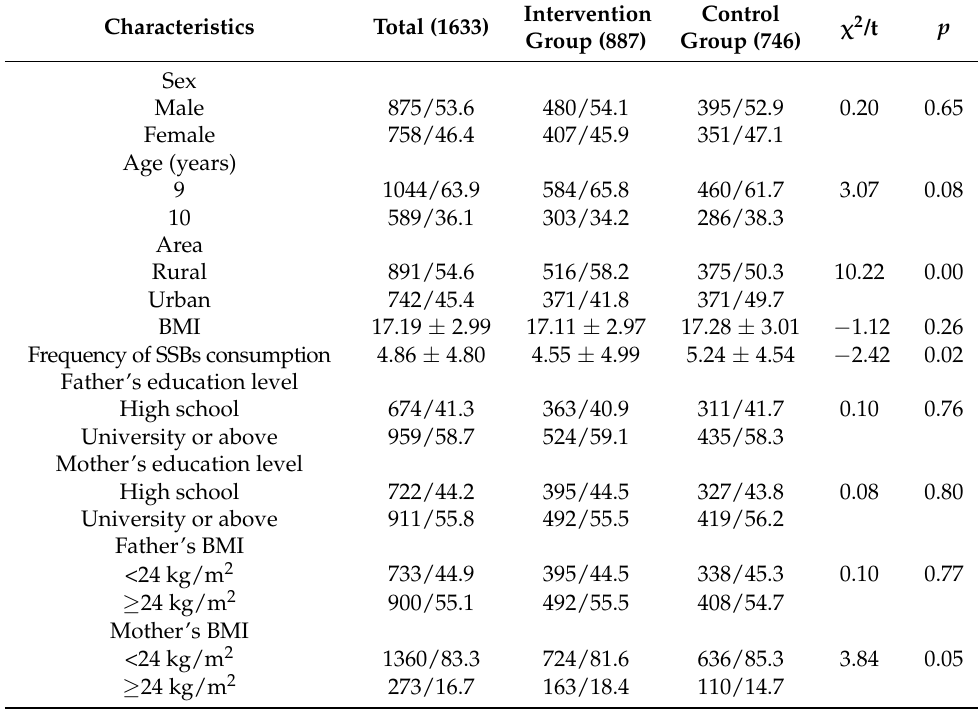
Table 2. Demographic characteristics of subjects (N/%, Mean ± SD).